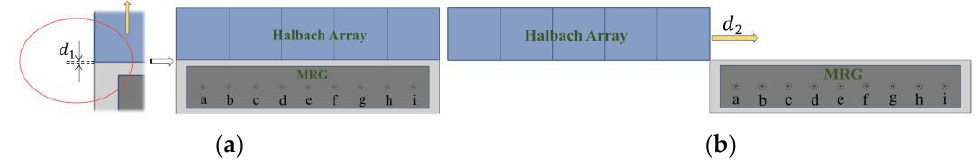
Figure 7. Schematic of Halbach array and MRG layer. ( a ) Longitudinal movement schematic; ( b ) Lateral movement schematic. Where the yellow arrow is the direction in which the Halbach array moves, d 1 is the longitudinal moving distance between the two and d 2 is the lateral moving distance between the two.